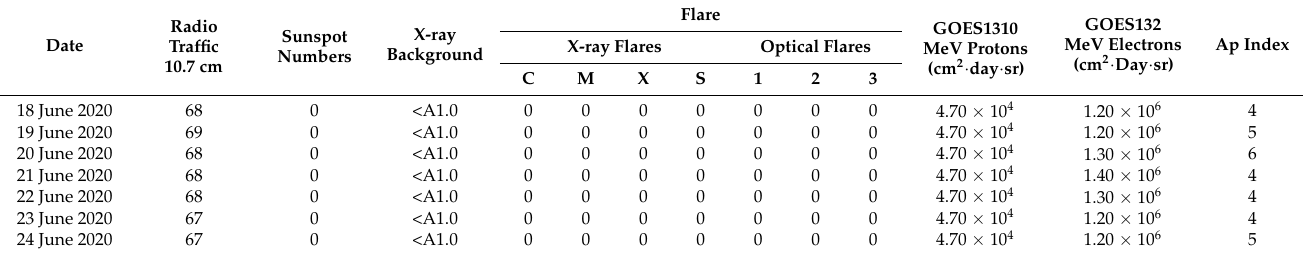
Table 6. Solar activity data during the period of 18–25 June 2020. (source: http://www.geomag.bgs.ac.uk/data_service/ space_weather/home.html (accessed on 6 February